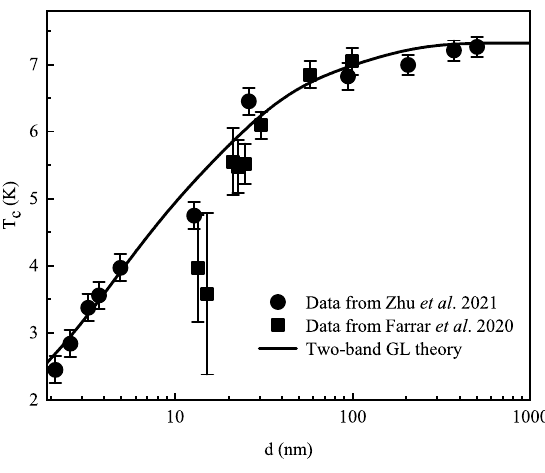
Figure 1. The critical temperature as a function of FeSe film thickness. The experimental data are taken from Ref. [18] (circles) and Ref. [19] (squares)